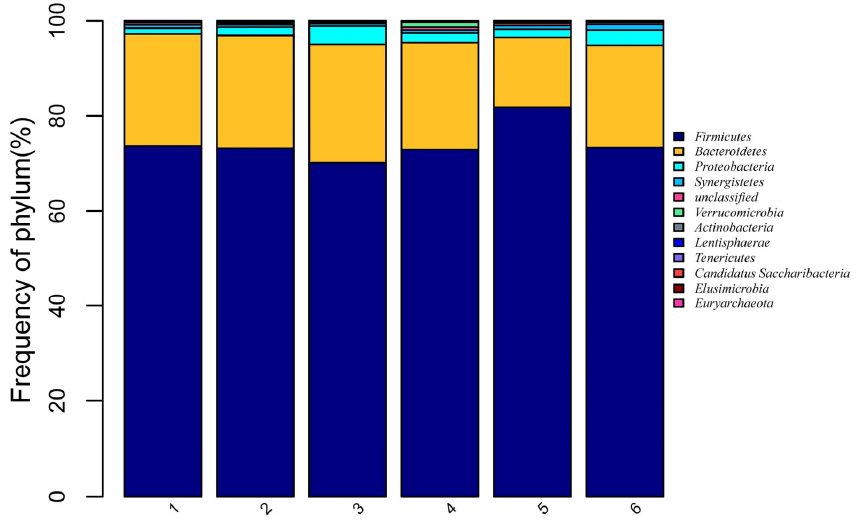
Figure 1. Effects of dietary digestible tryptophan (dTry) and soy oligossacharide (SO) supplementation on caecal microbial relative abundances in broiler chickens (at phylum level). The distribution barplot was drawn by using the barplot package of the R software. 1, 2, 3, 4, 5, 6 represent the 0.18%, 0.18%+SO, 0.23%, 557 0.23%+SO, 0.28%, 0.28%+SO treatments, respectively. 0.18%, 0.23%, and 0.28% refer to dTry level. 558 559